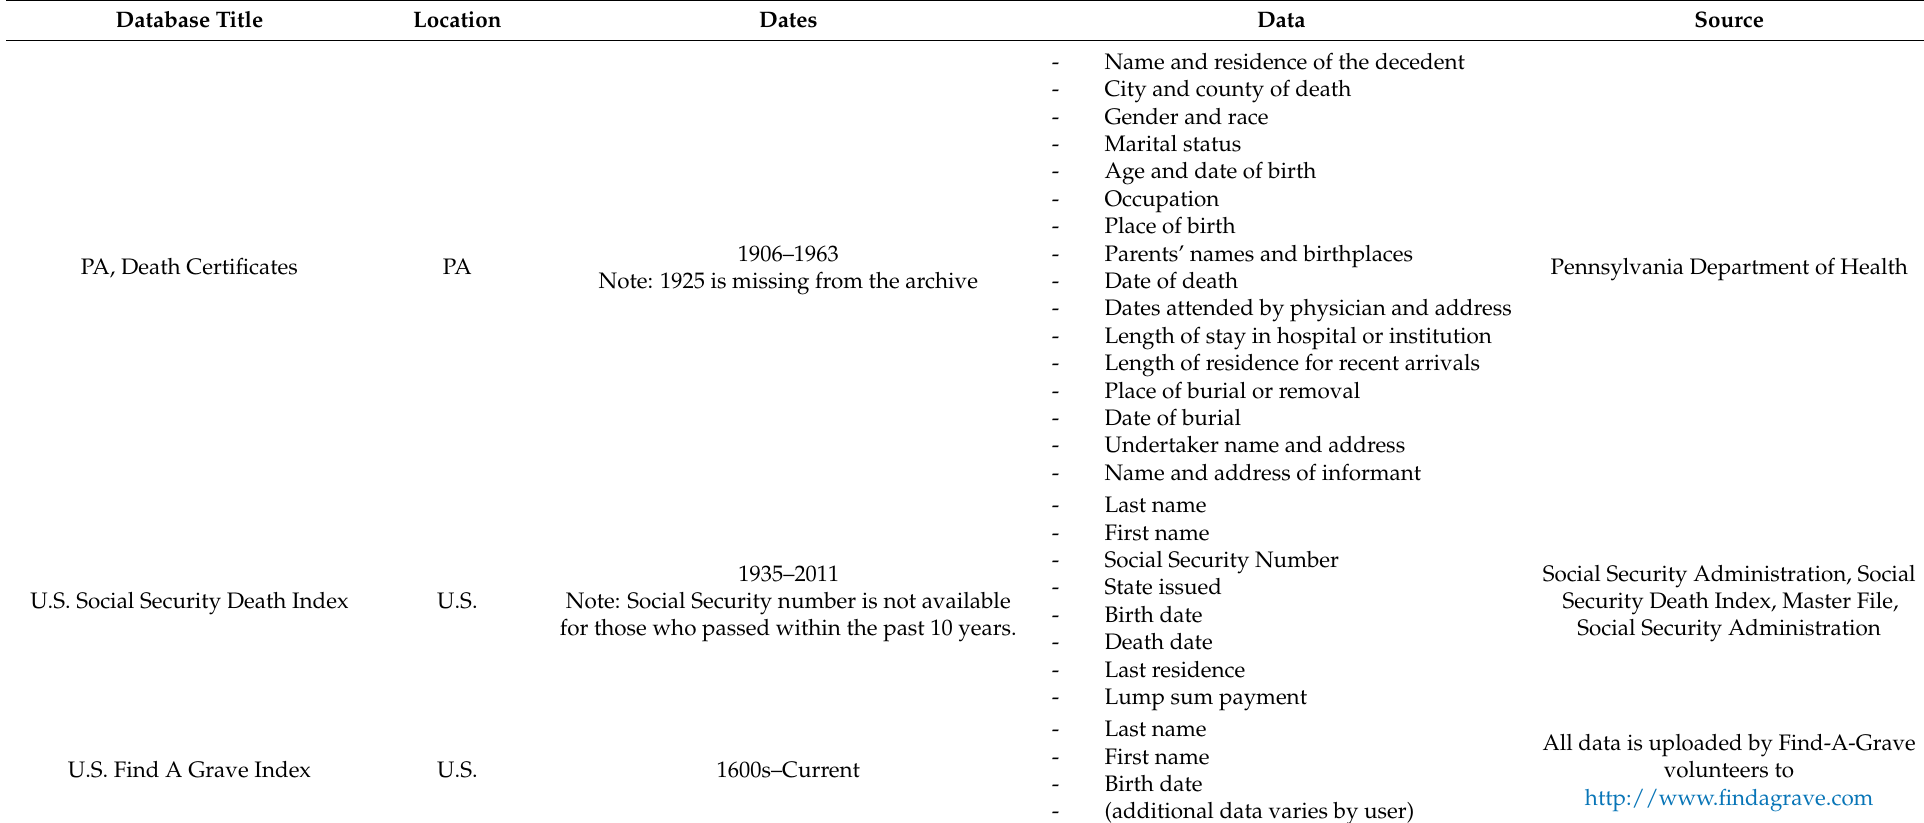
Table 1. Description of Ancestry.com databases as sources of death